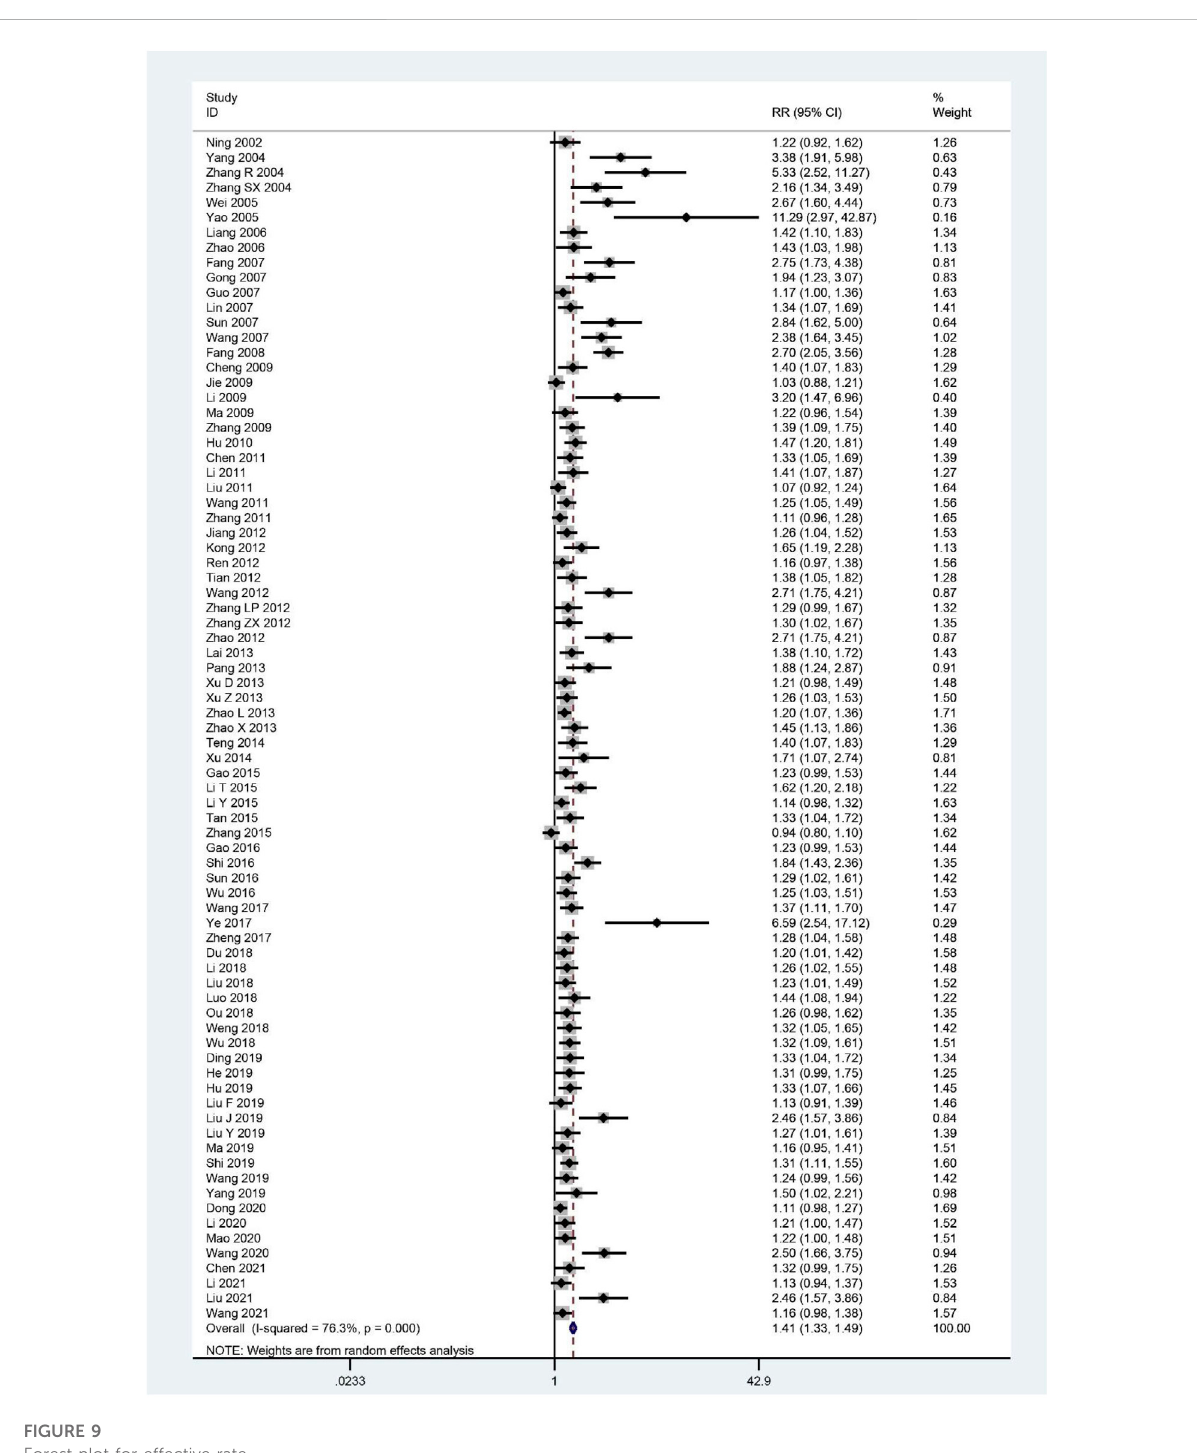
FIGURE 9 Forest plot for effective